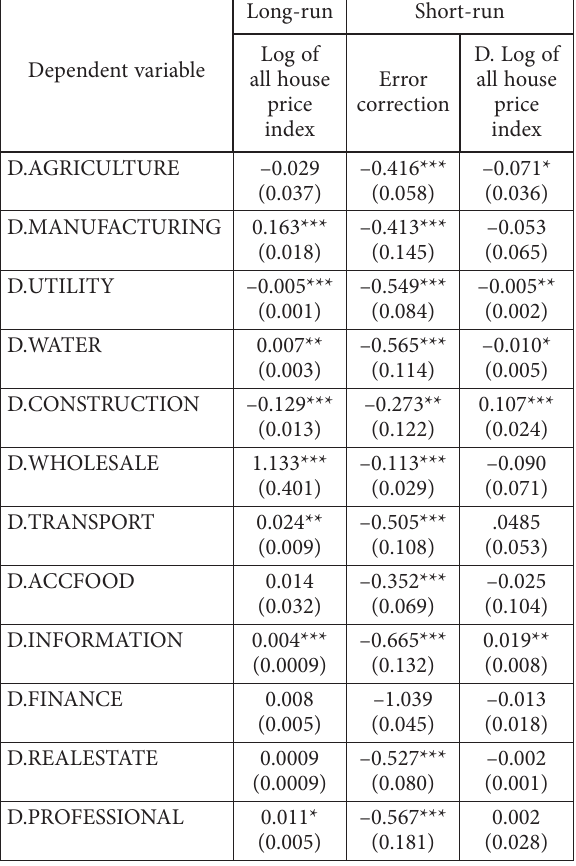
Table 8. All house price index (HP) and sub-sectoral business formation (with control